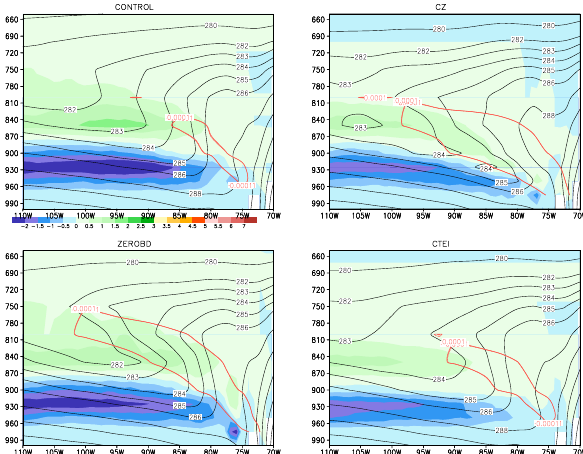
Fig. 10. Vertical cross-sections of ensemble monthly mean moisten- ing rates (g/kg/day) along 20 ◦ S (shaded) due to shallow convection in the four experiments. Black contours represent the vertical cross- section of temperature. Red contours represent estimated